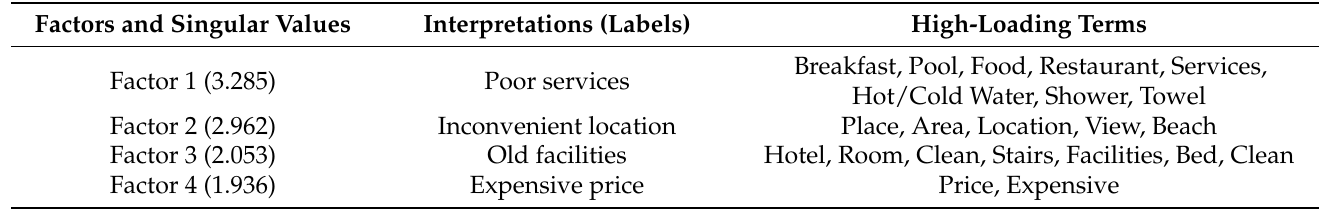
Table 3. Factors regarding customer